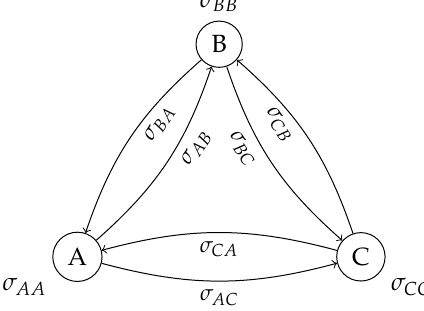
Figure 1. Sharing distribution with the ( 2,3 ) -threshold secret-sharing